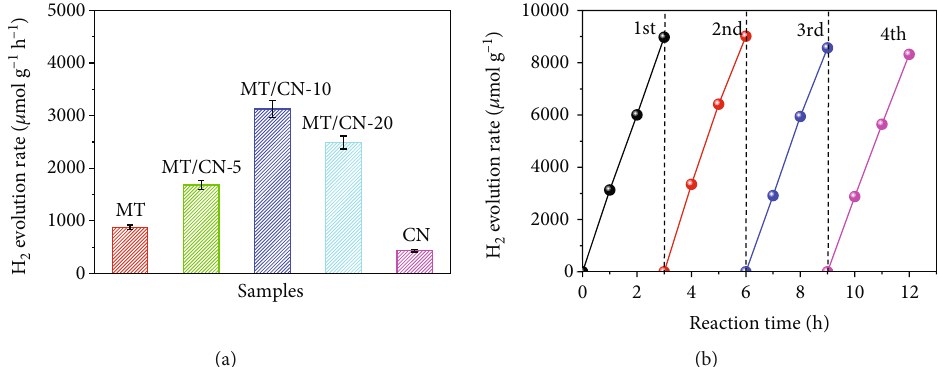
Figure 5: (a) Comparison of H generation rate of as-prepared samples under Xenon lamp irradiation (full spectrum), with photodeposition 2 of 1% Pt as cocatalyst. (b) Time courses of photocatalytic H generation amount of MT/CN-10. 2